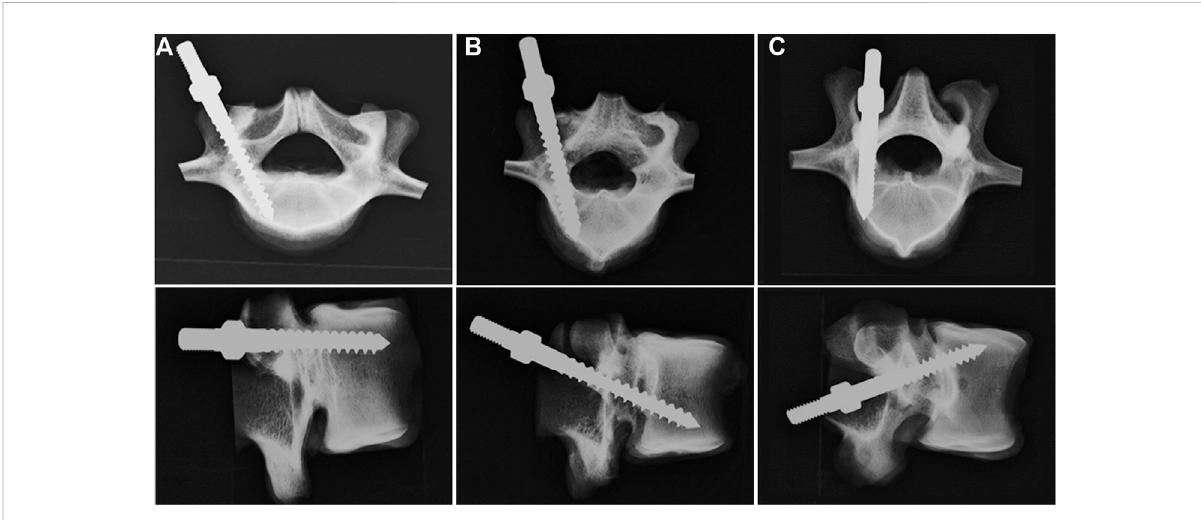
Axial (upper) and sagittal (lower) X-ray images of the vertebrae after the insertion of screws with (A) TT, (B) MT, and (C) CBT trajectories. In the axial view, the pedicle screws in the TT and MT groups were convergently inserted into the vertebral body, whereas in the CBT group, the screw was inserteddivergentlytowardthelateralcortex.Inthesagittalview,thescrewintheTTgroupwasparalleltothesuperiorendplate;intheMTgroup,the screw was inserted toward the anterior inferior edge of the vertebral body with proper depth. In the CBT group, the screw was placed 25 ° caudally toward the superior endplate. No fractures or lateral wall breach were detected in either view.